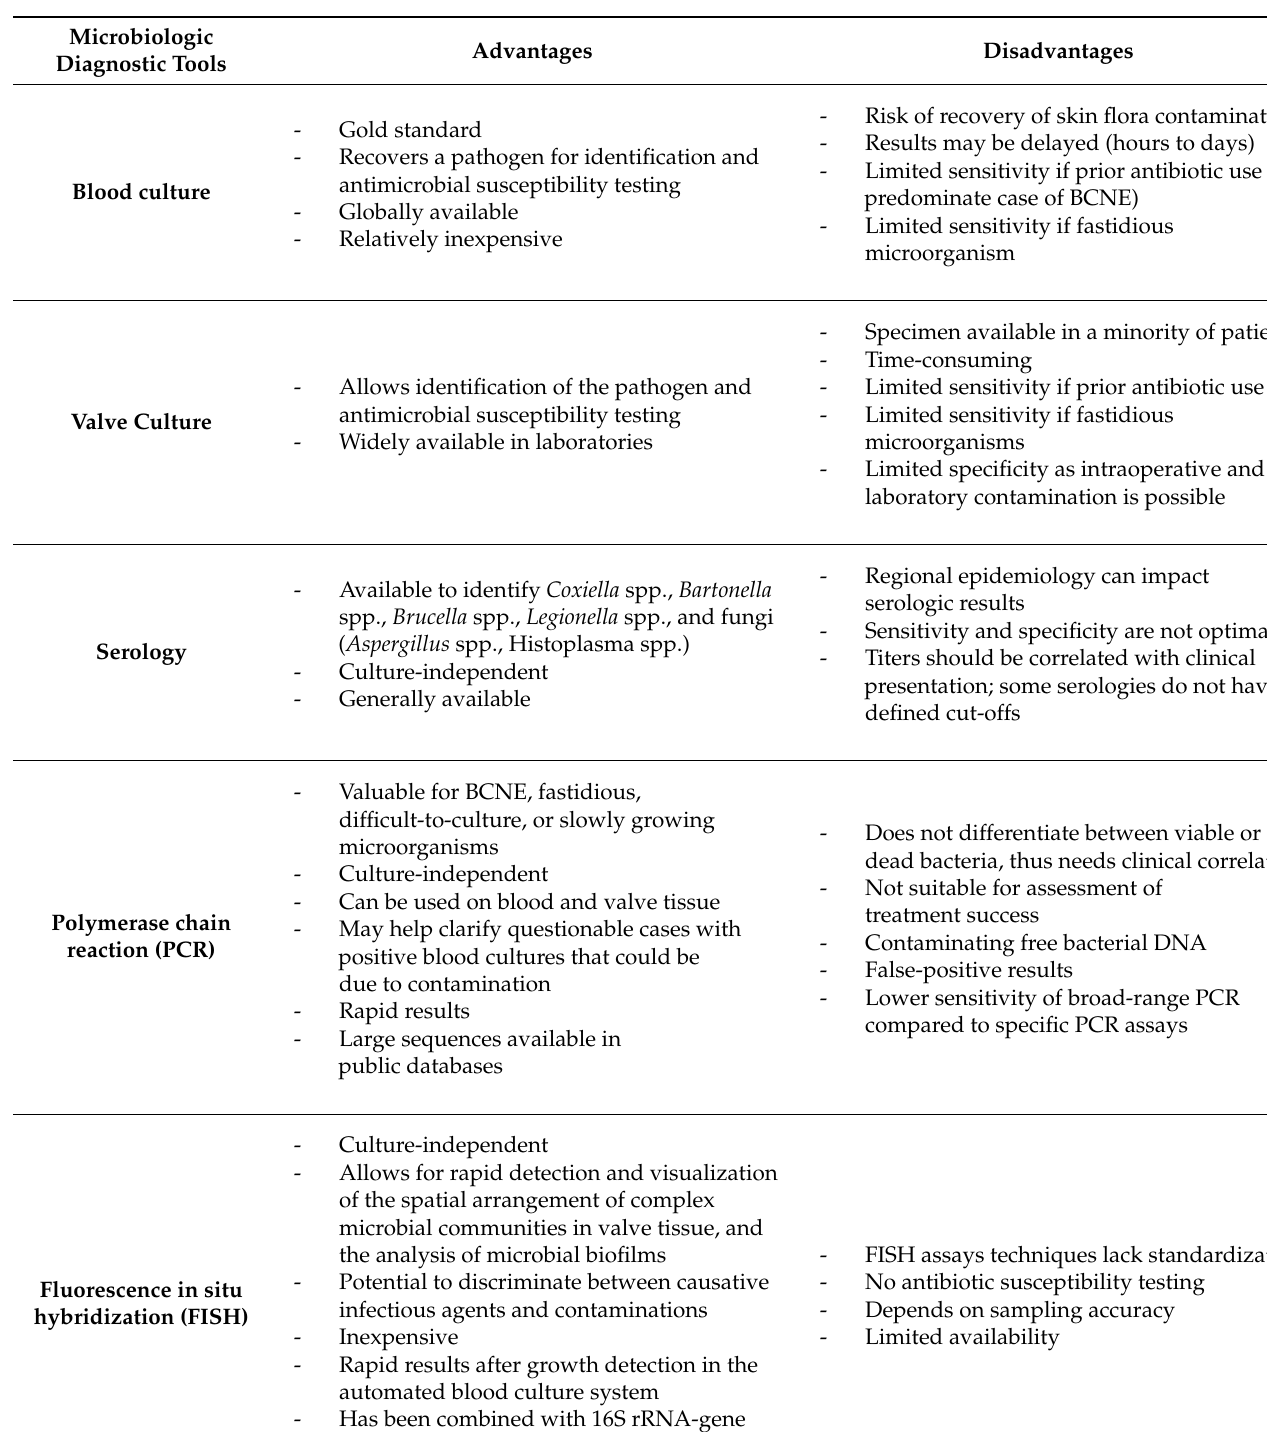
Table 3. Advantages and disadvantages of different microbiologic diagnostic tools in the workup of infective